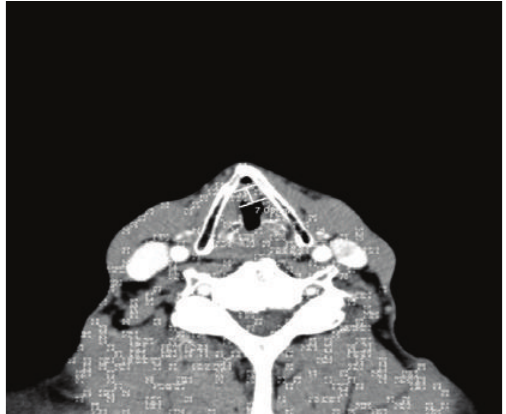
Figure 1: CT of the neck with contrast: There is 7mm polypoid mass involving the anterior commissure of the vocal cords. The nasopharynx, and pharynx, peripharyngeal spaces appear unremarkable, as well as the parotid and submandibular salivary glands. There is no significant neck adenopathy noted.